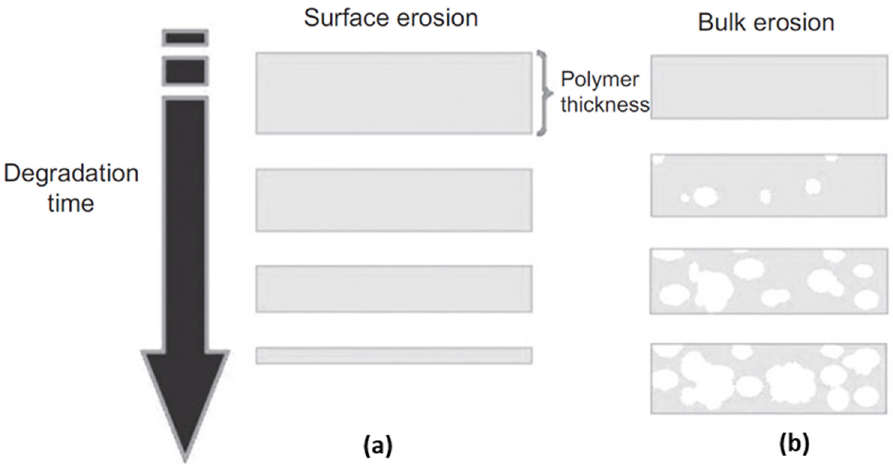
Figure 4. Schematic illustration of two types of erosion: ( a ) surface erosion and ( b ) bulk erosion with autocatalysis (adapted with permission [80] ©2013, Walter de Gruyter Berlin Boston).